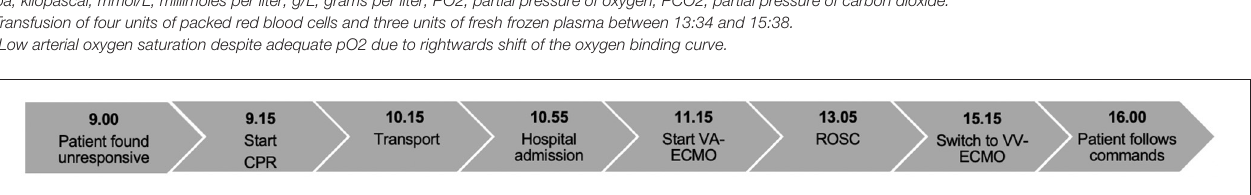
FIGURE 1 | Resuscitation timeline. CPR, cardiopulmonary resuscitation; ROSC, Return of spontaneous circulation; ECMO, Extracorporeal membrane oxygenation; min, minutes; VA, veno-arterial; VV,